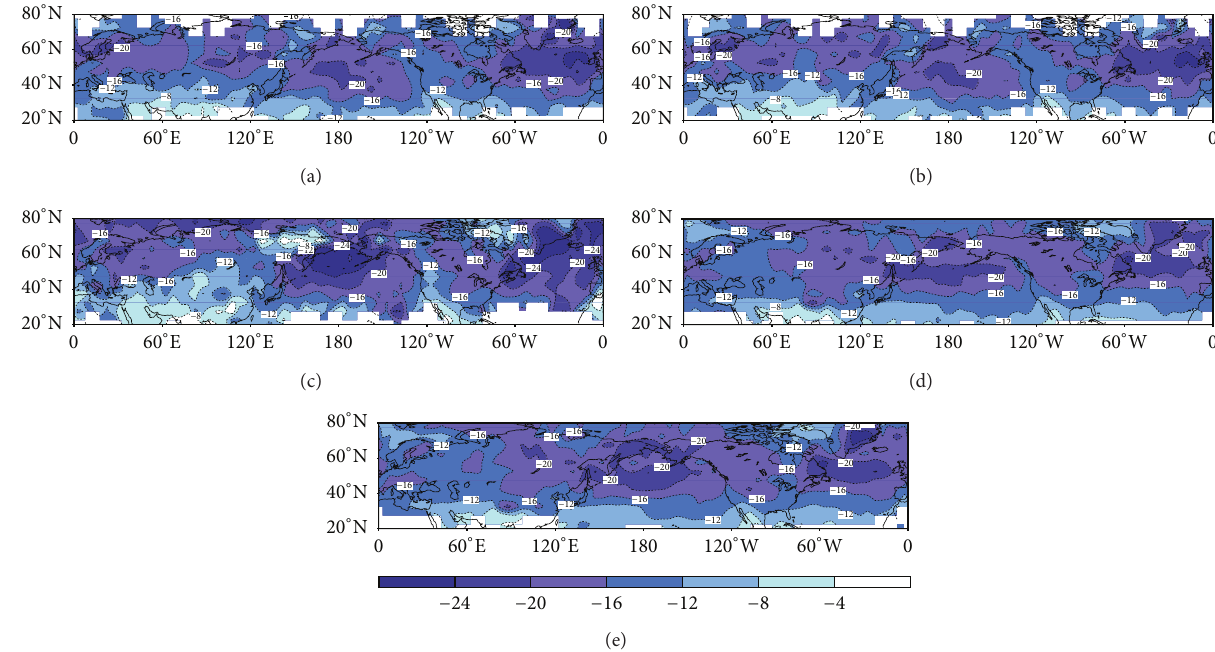
Figure 2: NH storm track intensity climatology for JFM (shaded). Intensity derived by subtracting regressed climatological mean from storm track mean (units: hPa) for (a) NCEP1, (b) ERA40, (c) CFSR, (d) CMIP1, and (e)